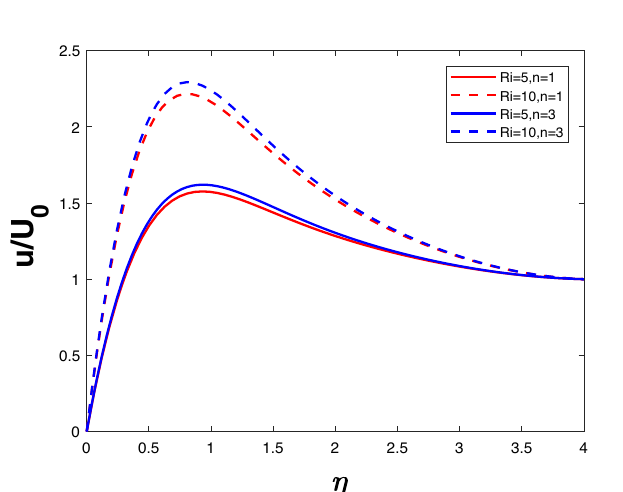
Figure 3. Velocity profile for various Ri .